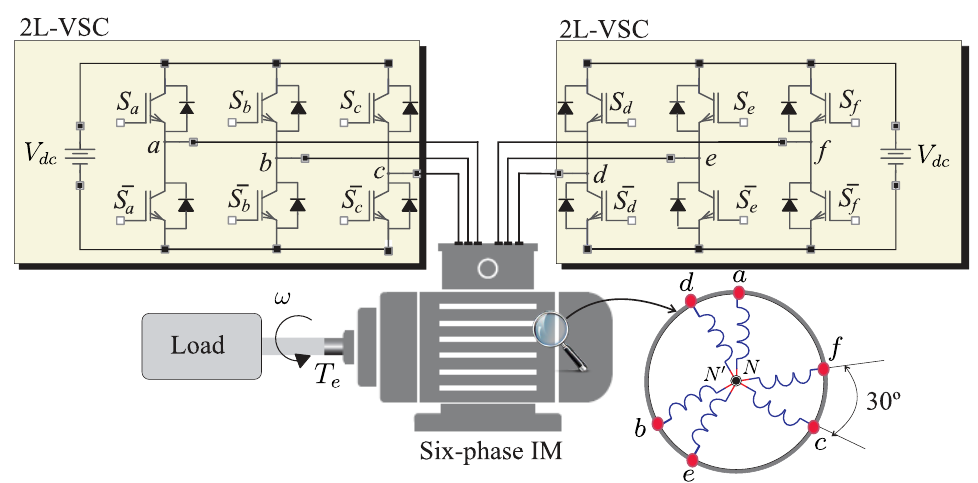
Figure 1. Studied six-phase IM powered by a six-leg